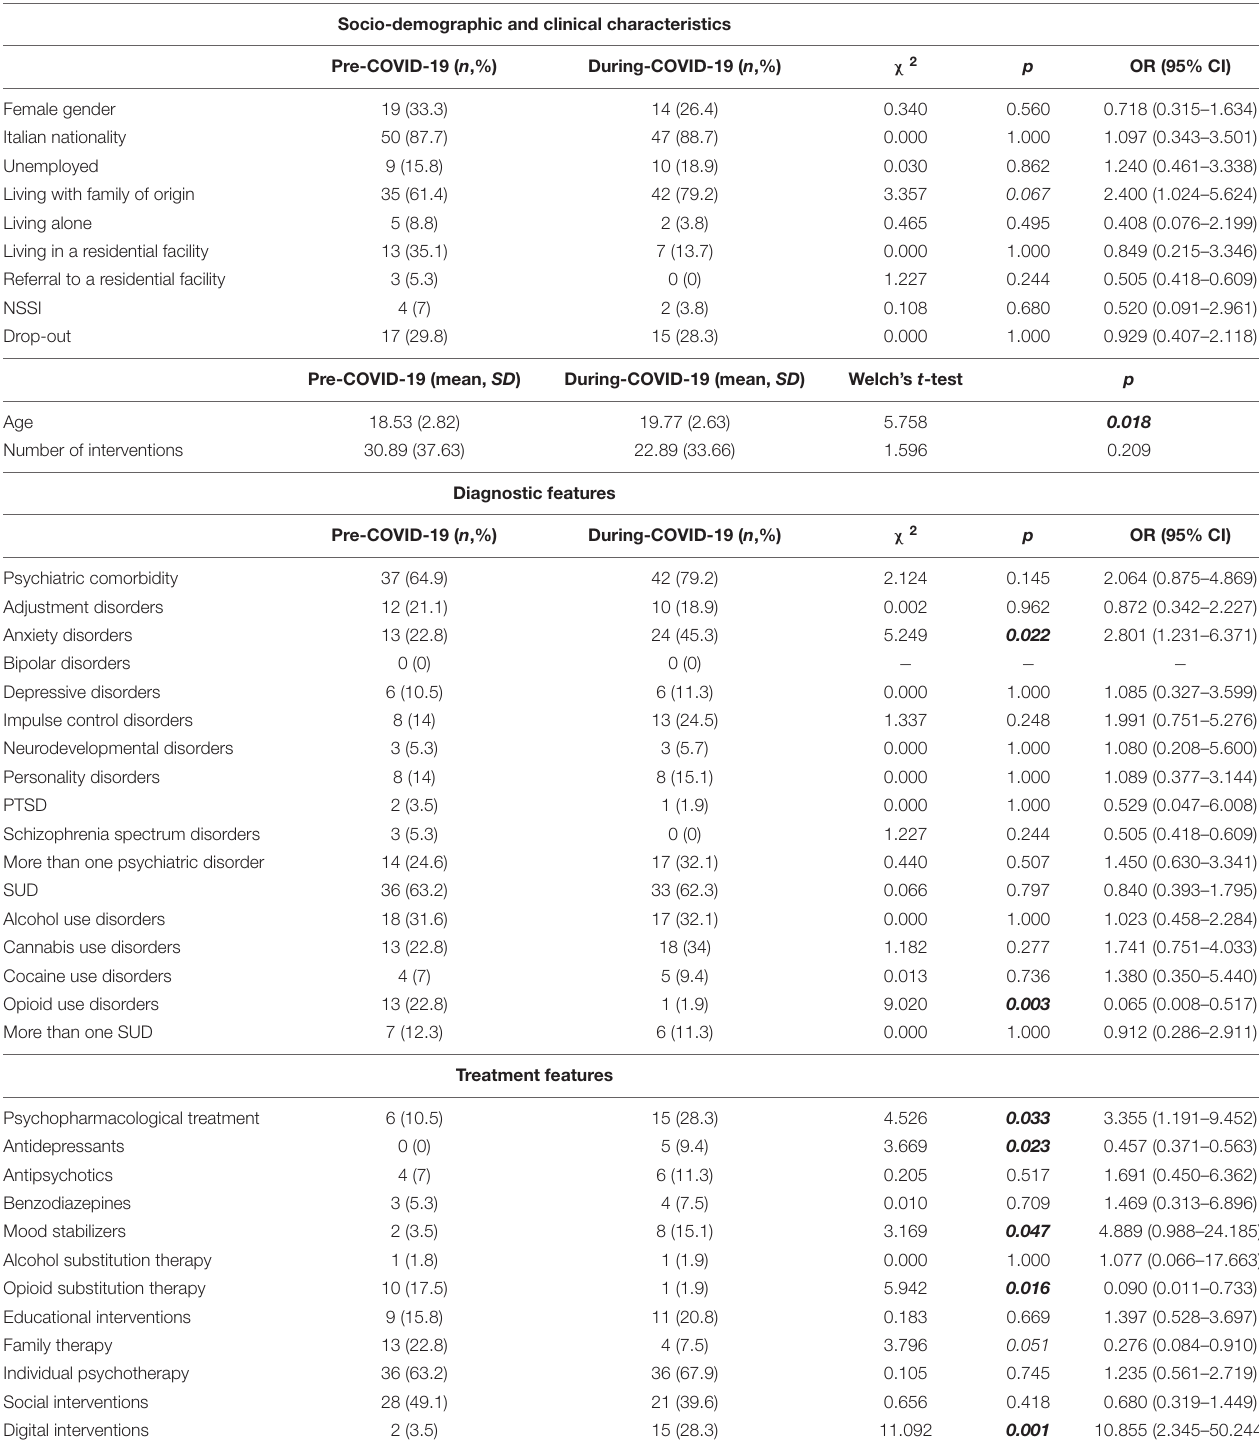
TABLE 1 | Comparison of socio-demographic and clinical characteristics of subjects accessing the service before (pre-COVID-19; n = 57, 51.8%) and after the COVID-19 pandemic outbreak (during-COVID-19; n = 53, 48.2%). Socio-demographic and clinical